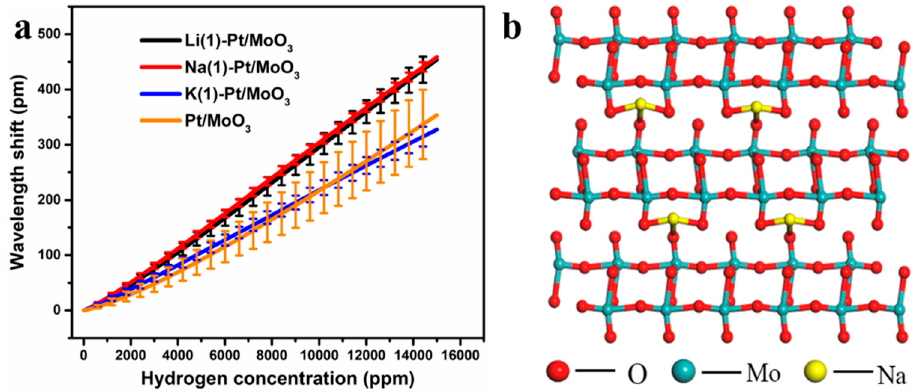
Figure 5. ( a ) Error analyses of Pt/MoO 3 , Li(1)-Pt/MoO 3 , Na(1)-Pt/MoO 3 , and K(1)-Pt/MoO 3 , ( b ) Schematic illustration of the crystalline structure of ion intercalated MoO 3 .